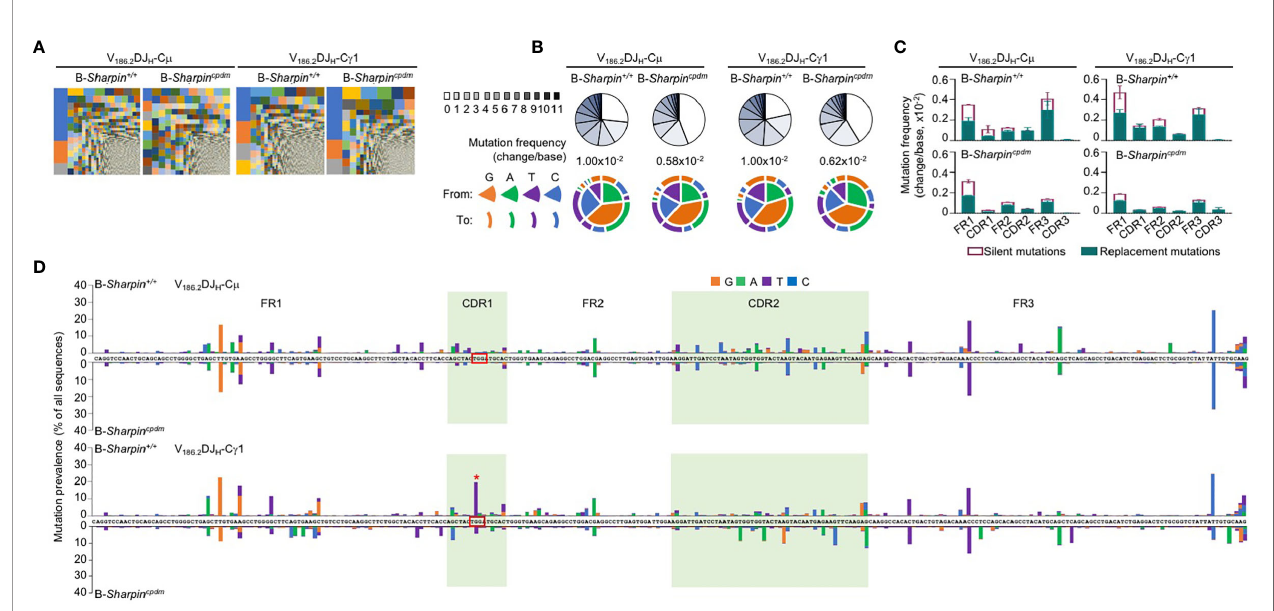
FIGURE 2 | SHARPIN mediates the generation of high-af fi nity BCR mutants. (A) Treemap charts depicting B cell clones identi fi ed by unique CDR3 sequences in the V H region of V 186.2 DJ H -C m and V 186.2 DJ H -C g 1 in B- Sharpin +/+ and B- Sharpin cpdm mice 14 d after NP-CGG/alum immunization. Each rectangle represents a unique clone and the size of each rectangle depicts the relative abundance of the clone within the total population. (B) Proportions of V 186.2 DJ H -C m and V 186.2 DJ H -C g 1 clones carrying given numbers of point-mutations in V 186.2 region in mice, as in (A) , as depicted by pie chart slices (top row; sequences with over 12 point-mutations were excluded from analysis), the overall mutation frequencies (middle), and the nature of such point-mutations, as depicted by concentric pie chart slices and rings (bottom row). (C,D) Histograms depict the silent and replacement mutations in different CDRs and FRs as well as in the entire V 186.2 DJ H -C m and V 186.2 DJ H -C g 1 regions (C) and the spectrum and distribution of point-mutations ( D , “ * ” denotes the G98->T98 mutation) in mice, as in (A,B) . Data are pooled from three mice in each